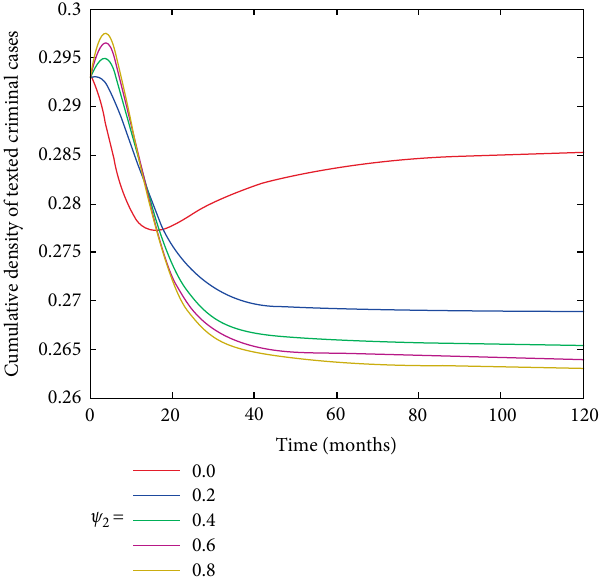
Figure 14: Simulation of model (4) showing the effect of varying the values of on the cumulative density of texted criminal cases as a 𝜓 2 function of time. Other parameter values used are as given in Table 3.